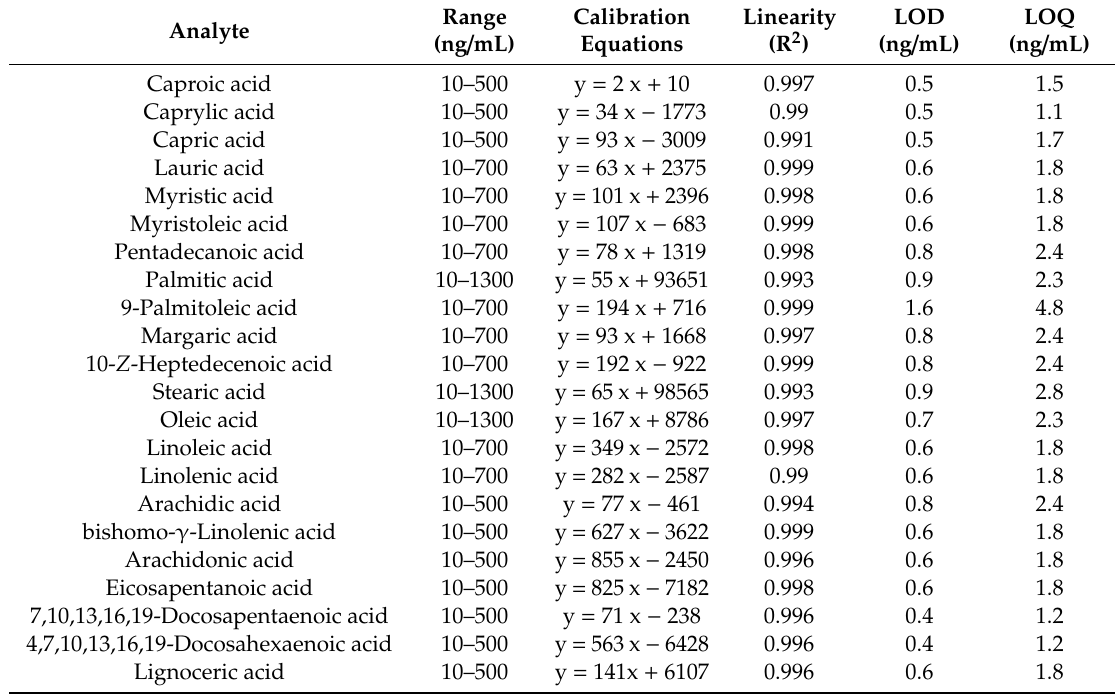
Table 2. Calibration curve data as well as limits of detection (LOD) and quantification (LOQ).